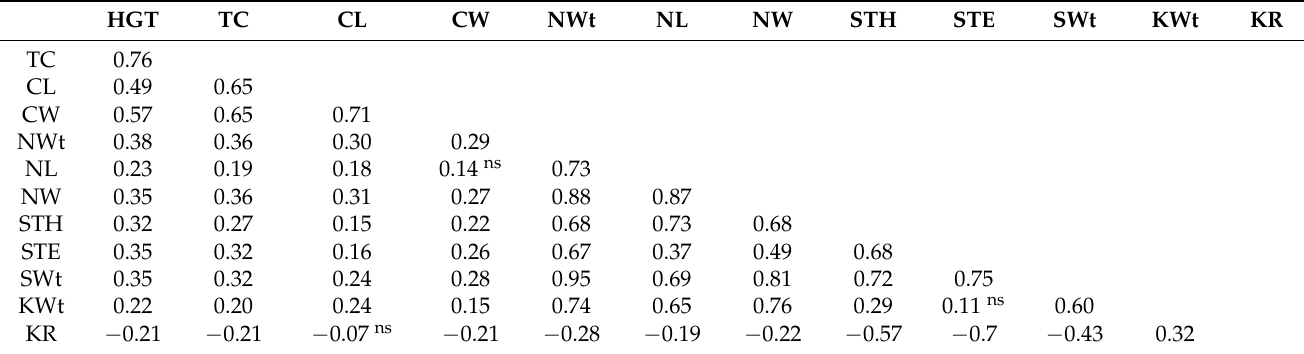
Table 3. Correlation coefficients among traits. HGT = height, TC = Trunk circumference, CL = Canopy length, CW = Canopy width, NWt = Nut weight, NL = Nut length, NW = Nut width, STH = Shell thickness at hilum, STE = Shell thickness at